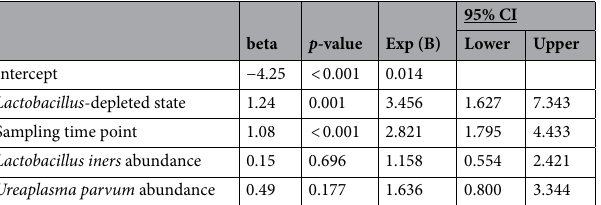
Table 6. Logistic regression analysis for predicting preterm birth. beta-values estimated using the multivariable logistic regression